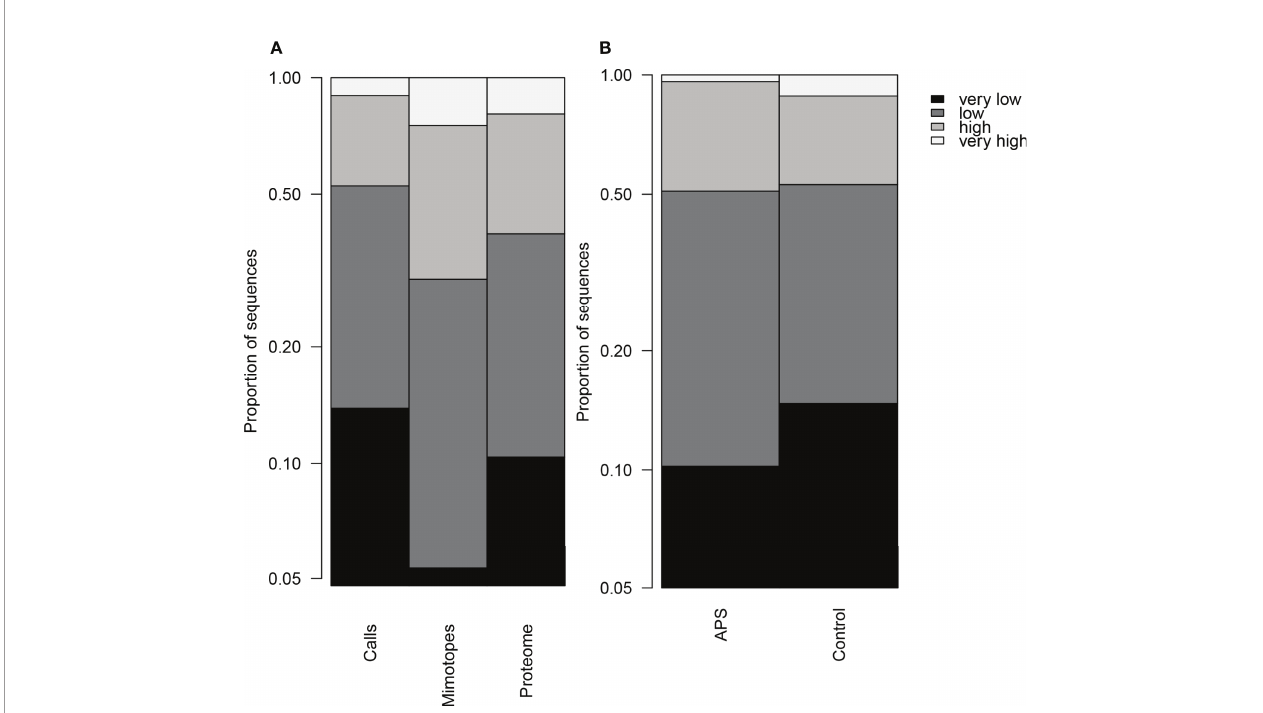
FIGURE 10 | Distribution of peptide sequences by entropy, the discrete entropy levels of 7-mer sequences calculated using the bias-corrected maximum likelihood method were pooled into 4 groups: very low – below 1.57 nats (typically at least 3 pairs or more repetitions), low - between 1.57 and 2 nats (2 pairs or a triplet), high – 2.1 nats (one pair), very high – 2.37 nats (7 different letters). (A) The proteome has low entropy skewed distribution relative to the mimotope library. The mimotopes found in the proteome sequences had an even stronger low entropy bias. (B) Among the differentially expressed reactivities, those over expressed in APS had lower proportion of lowest entropy sequences than those under